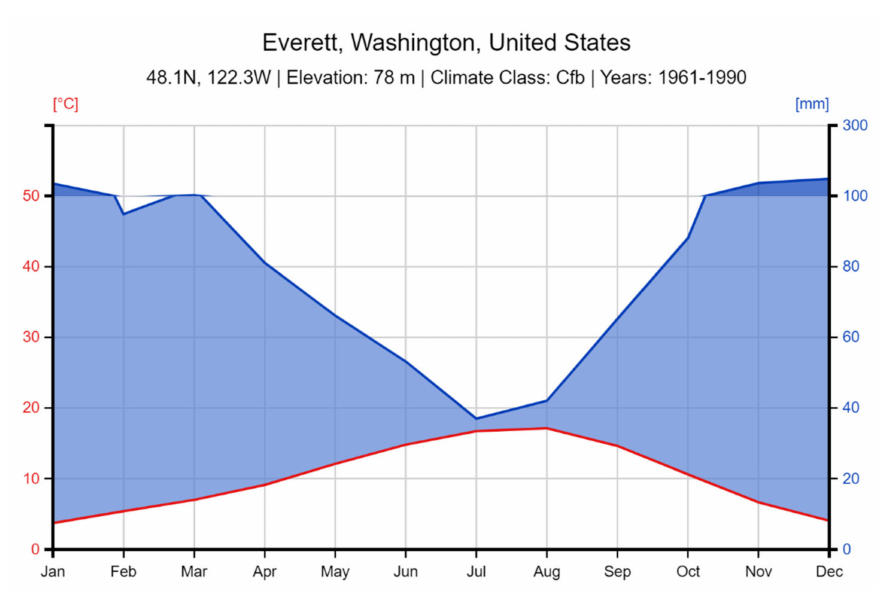
Figure 7. Climate chart of the weather station Everett, Washington (mean annual data for 1961–1990: temperature 10.3 ◦ C; precipitation: 950 mm). Note the “Sub-Mediterranean type” distribution of rainfall with minimum precipitation in